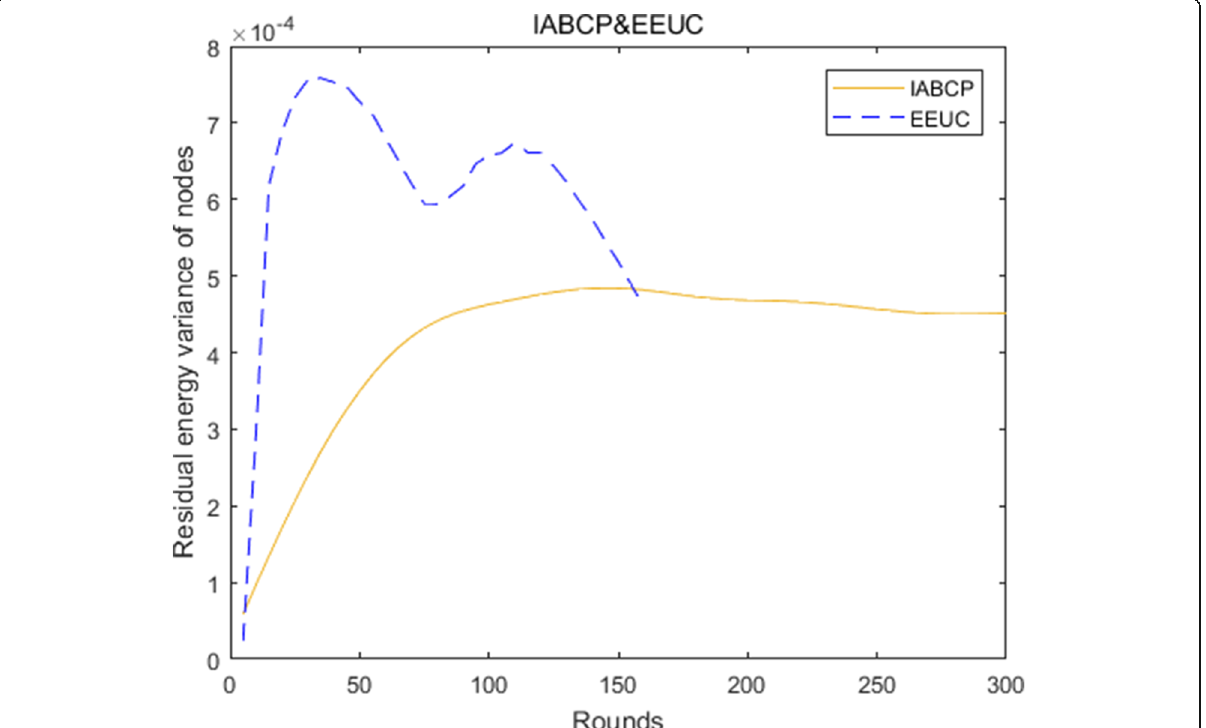
Fig. 11 Variance of residual energy of nodes. We use the variance of the residual energy of nodes to evaluate the load balance of a protocol. The more the variance, the closer the energy value of each node is, the better the load balance of the network